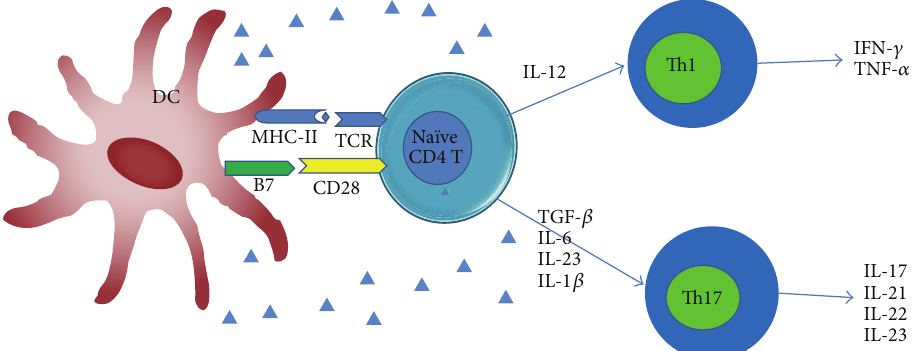
Figure 3: Dendritic cells (DCs) promote the differentiation of Th1 and Th17 cells. Mature DCs could induce the differentiation of naive CD4+ T cells into different types of T helper (Th) cells. Both Th1 and Th17 cells play pathogenic roles in the disease progression of MS mainly through their